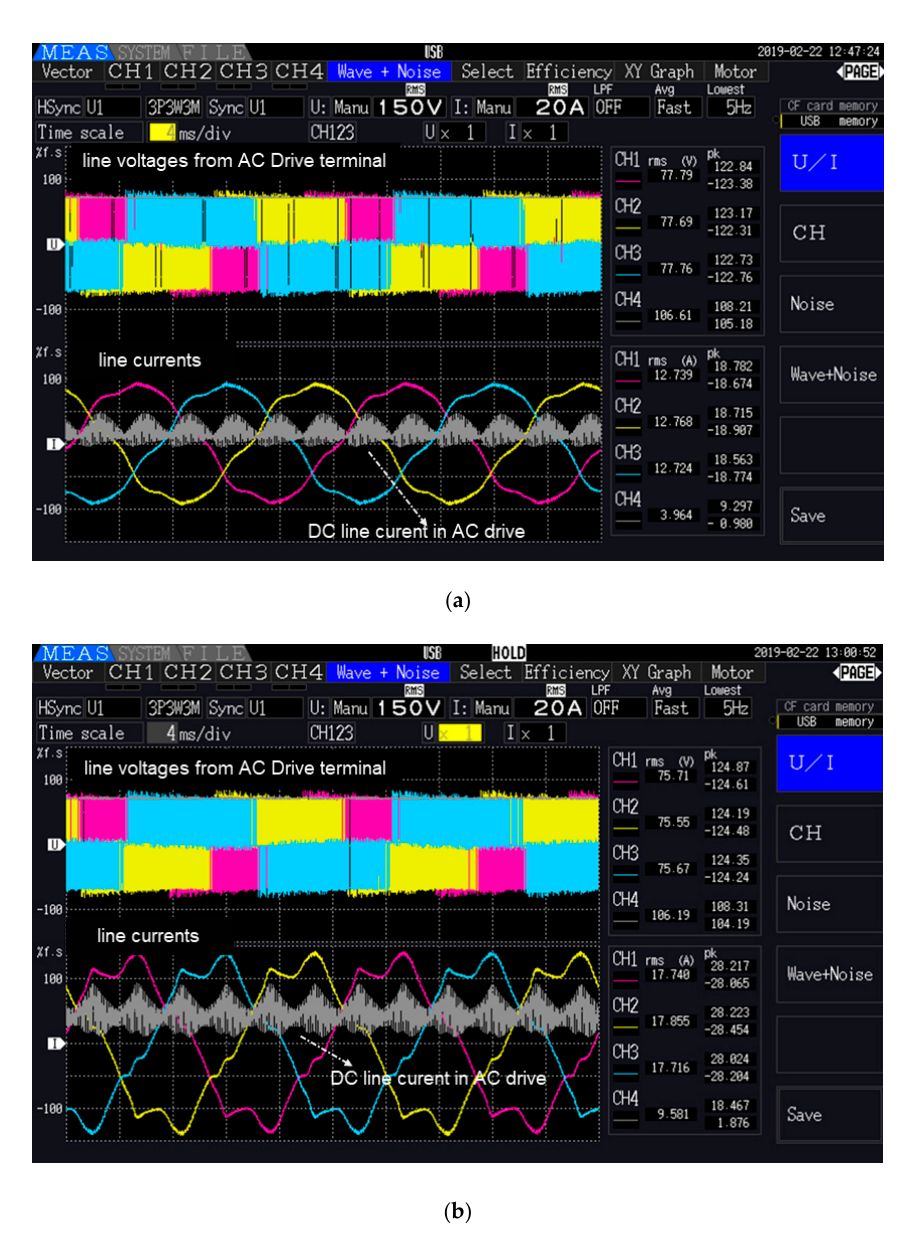
Figure 13. Line-to-line stator voltages and line currents wave throughout the AC motor drive. ( a ) with no load condition. ( b ) under the relatively over load more about 20%.